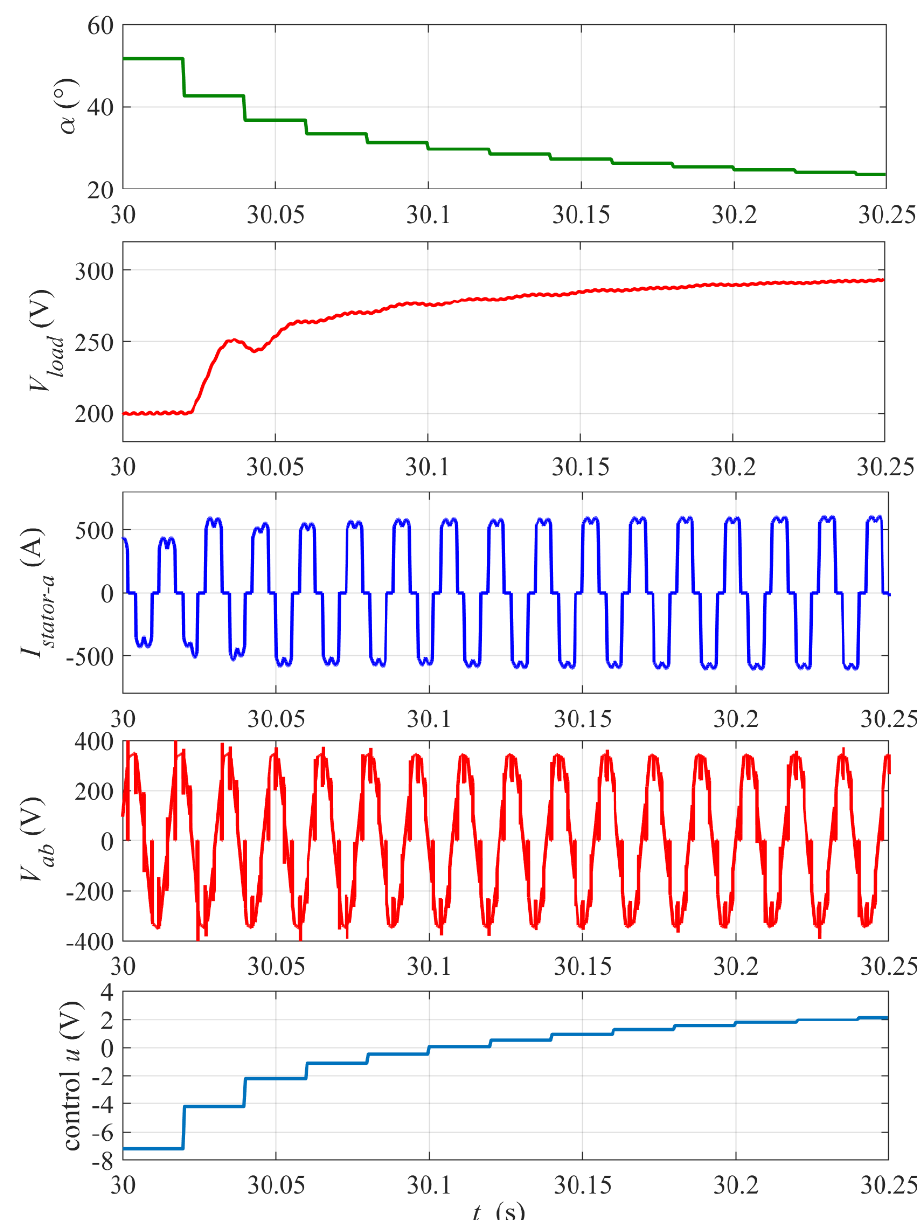
Figure 10. Dynamic response of the system to the step change in the reference output voltage V load_ref from 200 V to 300 V at time t step = 30 s. Zoomed-in view of waveforms from Figure 8. The digital control update period T sc = 20 ms.